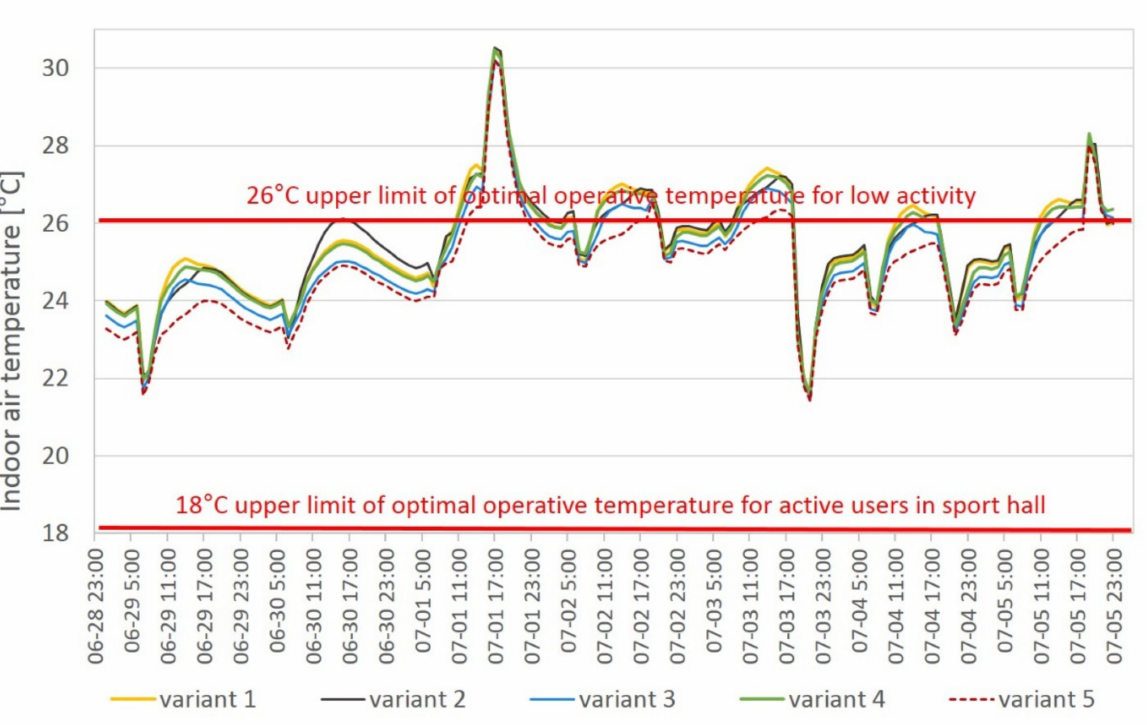
Figure 9. Indoor air temperature distribution for the selected week. The differences of 0.0–1.2 ◦ C depend on the hourly interval and the day of the week and the related thermal loads of the building. The red dashed graph (variant 5) is charac- terized by the lowest values of internal temperature in relation to the remaining options. The greatest disproportion in values occurs between 1 p.m. and 3 p.m. due to the use of shading at that